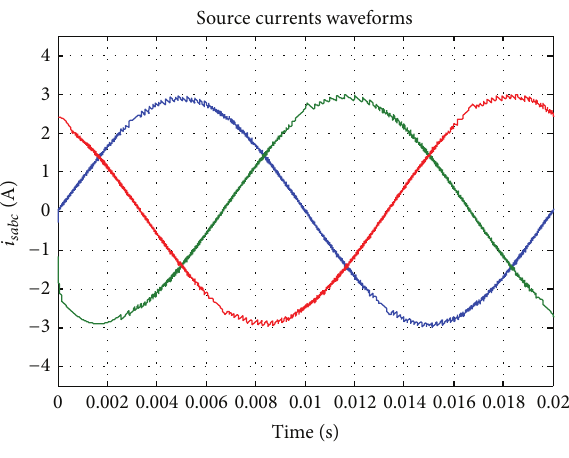
Figure 15: Zoom of source currents waveform.